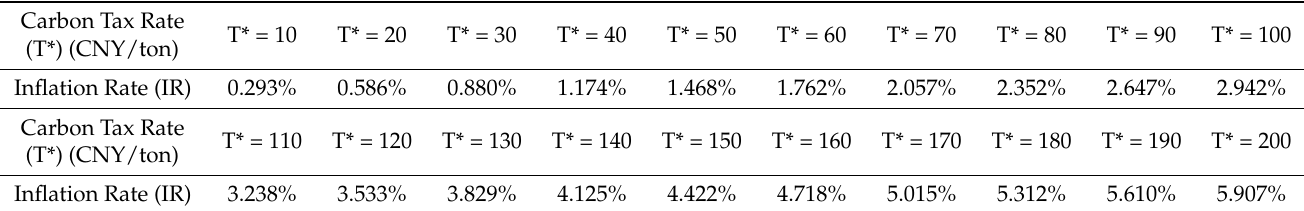
Table 2. The relationship between carbon tax and inflation rate.